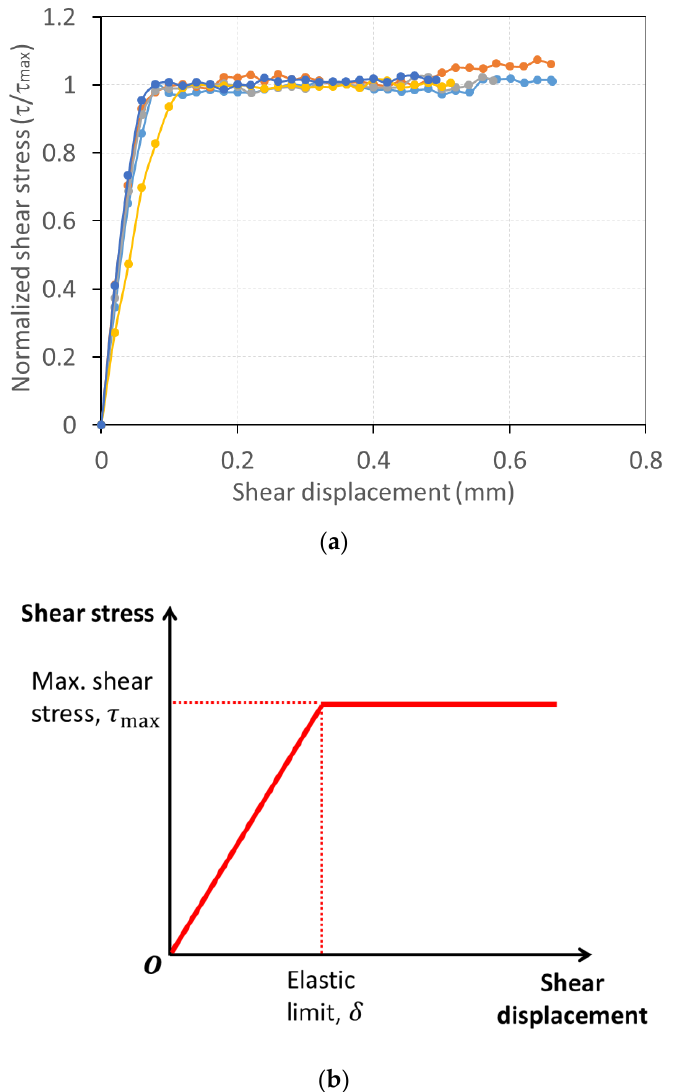
Figure 3. Results of the direct shear test at the acryl-wood interface; ( a ) normalized shear stress versus shear displacement from the multiple direct shear tests under the various range of normal stresses (results shown here are for 10 kPa of normal stress as an example), and ( b ) conceptual idealization of the direct shear test result.